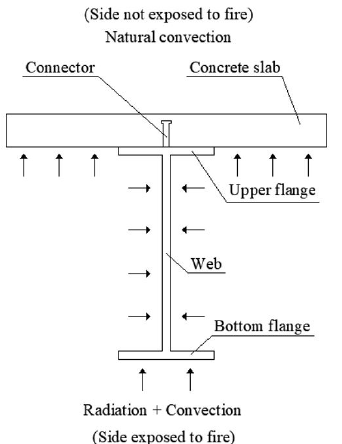
Figure 1. Proposed model of composite steel and concrete beam in a fire